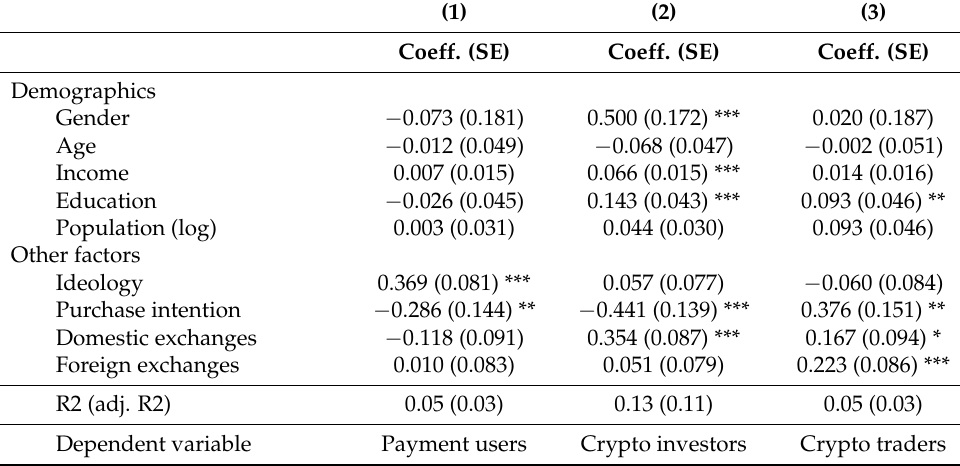
Table 3. Profiling Turkish cryptocurrency owners based on demographics and other